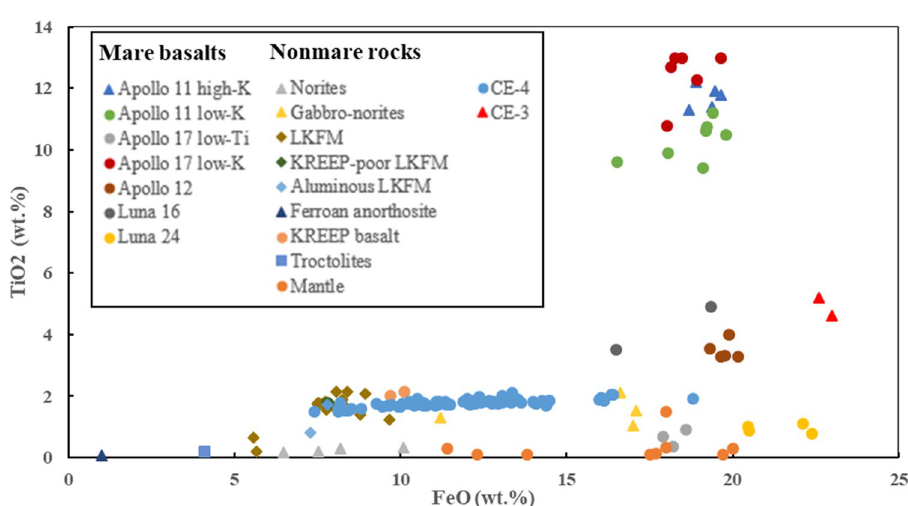
Figure 4. Chemical properties of CE-4 measured materials. The LKFM (11.4–20 wt% FeO, 0.1–0.34 wt% TiO 2 ) is a rock type thought to compose the lower lunar crust. The lunar mantle (11.4–17.5 wt% FeO and 0.1–0.34 wt% TiO 2 ) compositions are inferred by the experiments at high temperatures and pressure of mare basalt source regions in the lunar mantle which may lead to the elevation of TiO 2 . Mare basalts shows the range of 16.5–22.4 wt% FeO and 0.36–12.99 wt% TiO 2